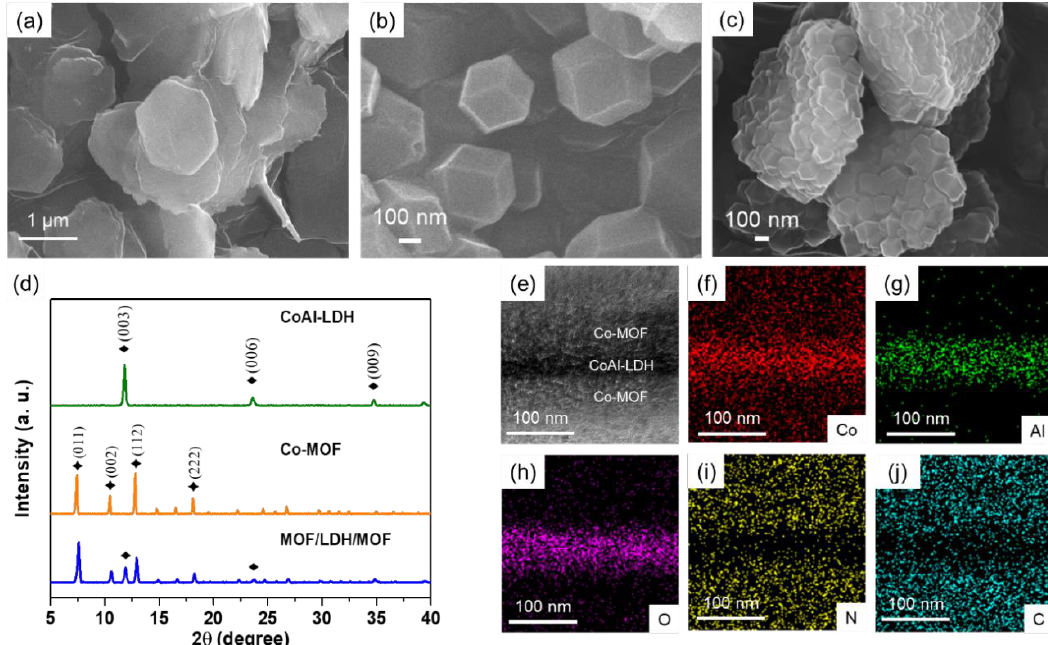
Figure1. SEMimagesof( a )cobaltaluminumlayereddoublehydroxide(CoAl-LDH);( b )Co-basedmetal Figure 1. SEM images of ( a ) cobalt aluminum layered double hydroxide (CoAl-LDH); ( b ) Co-based organic frameworks (Co-MOF) and ( c ) MOF / LDH / MOF; ( d ) XRD patterns of CoAl-LDH, Co-MOF and metal organic frameworks (Co-MOF) and ( c ) MOF/LDH/MOF; ( d ) XRD patterns of CoAl-LDH, Co- MOF / LDH / MOF; ( e ) The cross-sectional TEM images of MOF / LDH / MOF and ( f – j ) the corresponding MOF and MOF/LDH/MOF; ( e ) The cross-sectional TEM images of MOF/LDH/MOF and ( f – j ) the element mapping images of Co, Al, O, N, and corresponding element mapping images of Co, Al, O, N, and C.